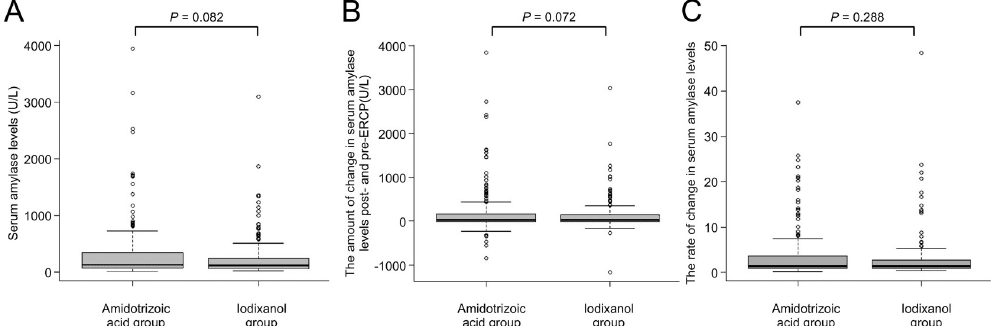
Fig 2. (A) Serum amylase levels post-ERCP in the amidotrizoic acid and iodixanol groups after propensity score matching. ( B) The amount of change in serum amylase levels post- and pre-ERCP (post-ERCP amylase levels were subtracted from pre-ERCP amylase levels) in the amidotrizoic acid and iodixanol groups. (C) The rate of change in serum amylase levels post- and pre-ERCP (post-ERCP amylase levels were divided by pre-ERCP amylase levels) in the amidotrizoic acid and iodixanol